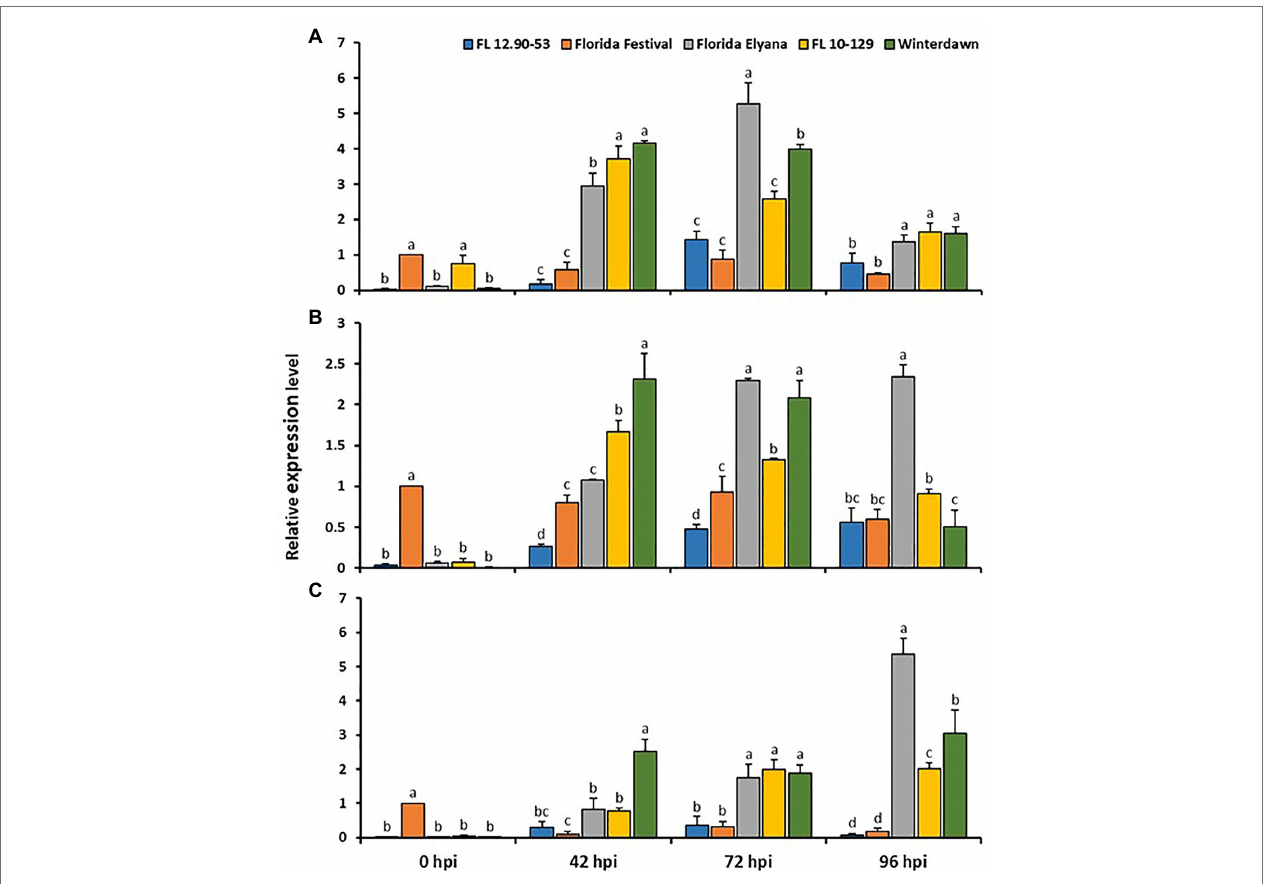
FIGURE 5 | The qRT-PCR experiment for the selected upregulated genes in the FaRCg1 region-based RNA-Seq analysis (A) TIFY 11A (B) Subtilisin-like protease, and (C) von Willebrand factor A domain containing protein. The crown tissues from all the resistant and susceptible accessions were used for both pathogen- inoculated and water-inoculated at 0, 42, 72, and 96 h post inoculation (hpi). Water-inoculated susceptible ‘Strawberry Festival’ at 0 hpi was referred as calibrator. The accession FL 12.90-53 and ‘Strawberry Festival’ are susceptible to CCR, whereas FL 10-129, ‘Winter Dawn’ and ‘Florida Elyana’ are resistant to CCR. The calculation of relative quantification of genes was performed by 2 - ΔΔ Ct method. Glyceraldehyde 3-phosphate dehydrogenase ( GAPDH ) was used as a housekeeping gene for normalization and the mean SD of data from three biological replicates was used for making the graph. Values with different letters are significantly different at p < 0.05, as assessed using Duncan’s multiple-range test. Error bars represent + SE of the means of three independent